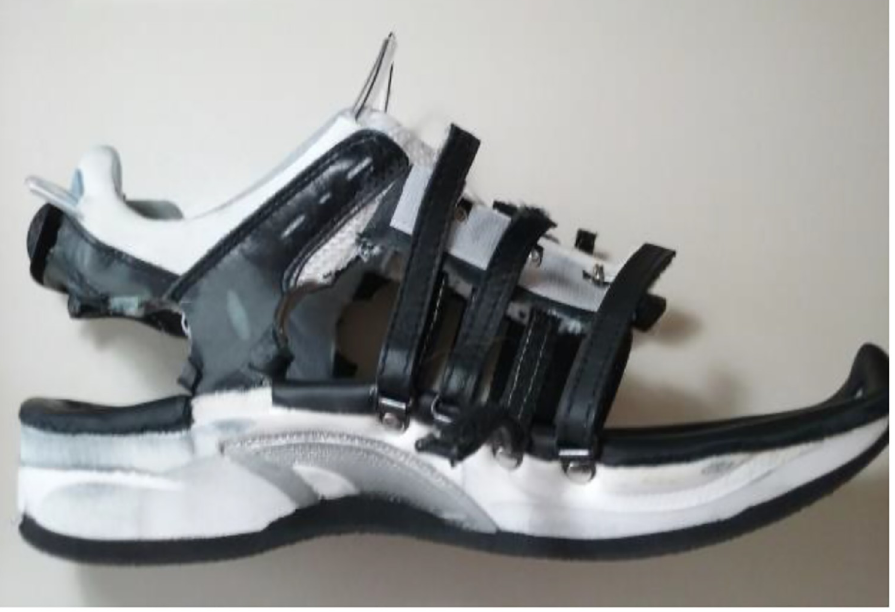
Fig 3. Experimental